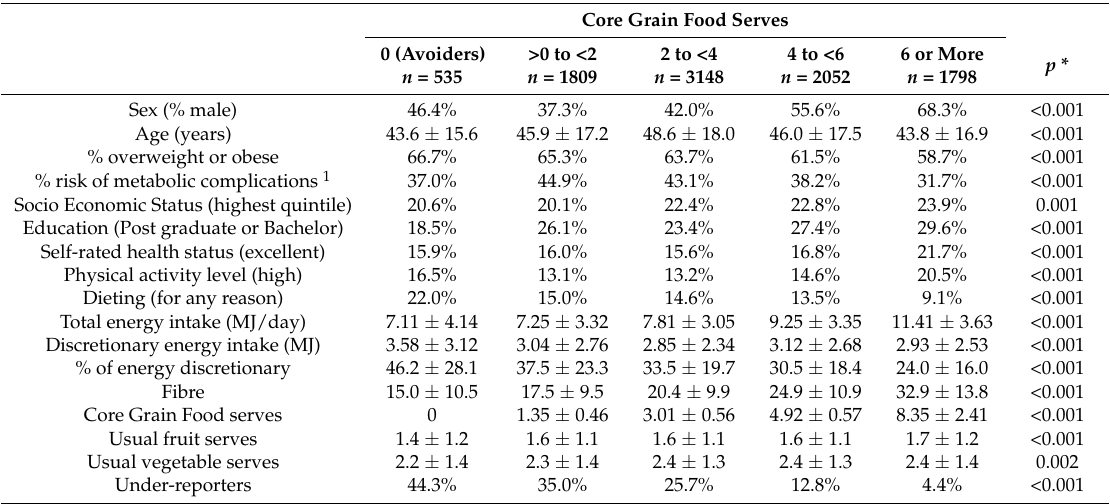
Table 1. Descriptive characteristics by core grain food serves (mean ± SD, or